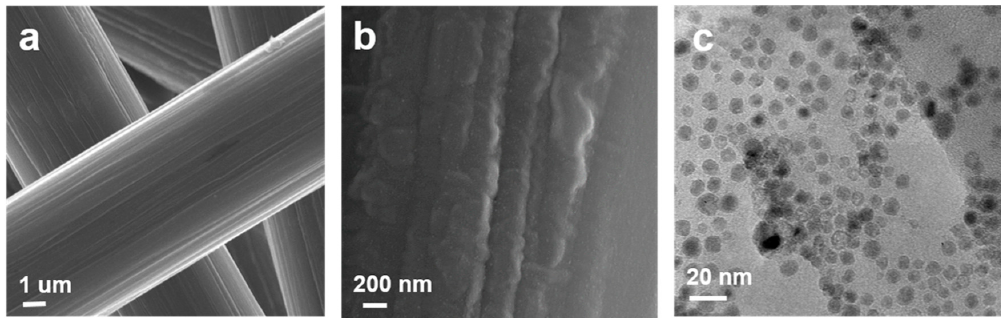
Figure 2. Microstructural of NiO/Ni nanoparticles loaded on carbon fiber paper. ( a , b ) Scanning electron microscopic (SEM) images; and ( c ) transmission electron microscopic (TEM) image.